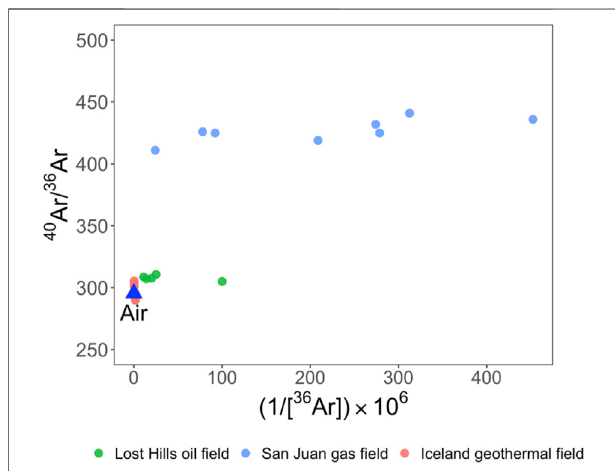
FIGURE 3 | 40 Ar/ 36 Ar ratios vs. 1/ 36 Ar. 40 Ar/ 36 Ar ratios in gas samples collected from San Juan Basin are signi fi cantly higher than the air value of 298.6 (Lee et al., 2006), suggesting the addition of a radiogenic Ar component. Data sources: Lost Hills oil fi eld (Barry et al., 2018), San Juan gas fi eld (Zhou et al., 2005), and Iceland geothermal fi eld (Byrne et al., 2021).